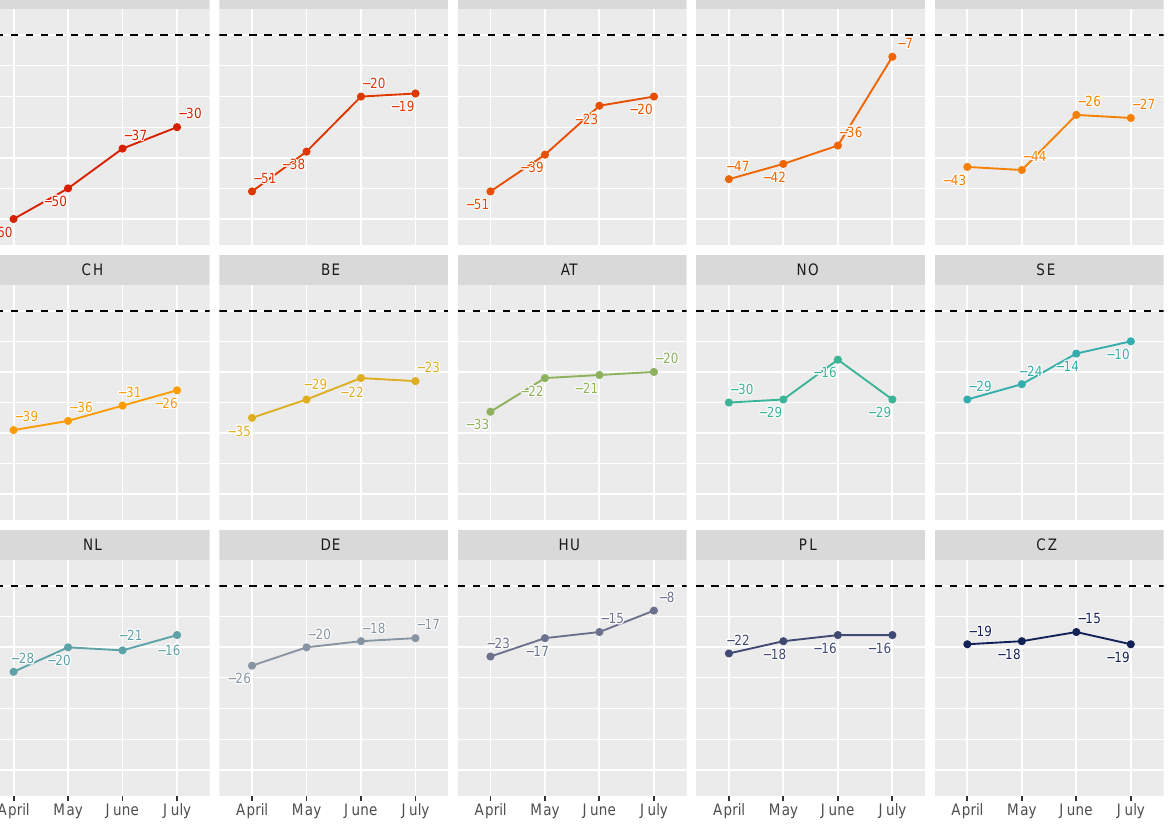
Figure 7. The median relative drop in NO 2 concentration at all urban and suburban sites is given by the difference between the GAM predicted and observed level in April–July 2020. Only countries with at least ten sites are